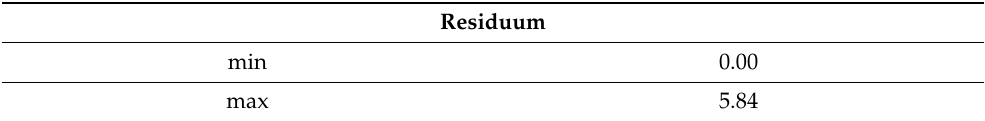
Table 19. Minimum and maximum value of